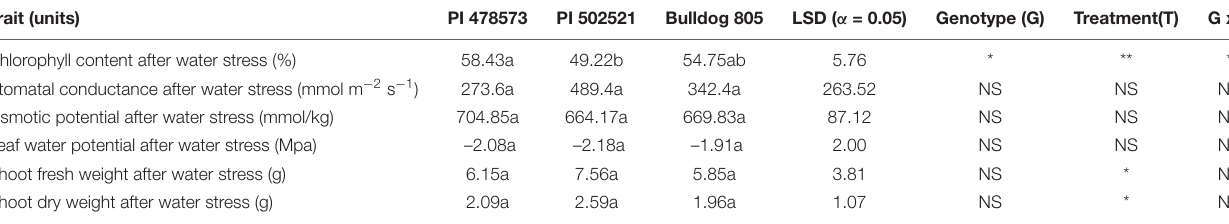
TABLE 2 | Physiological and biomass traits of the above ground (shoots) and root tissues from three alfalfas evaluated in Exp.